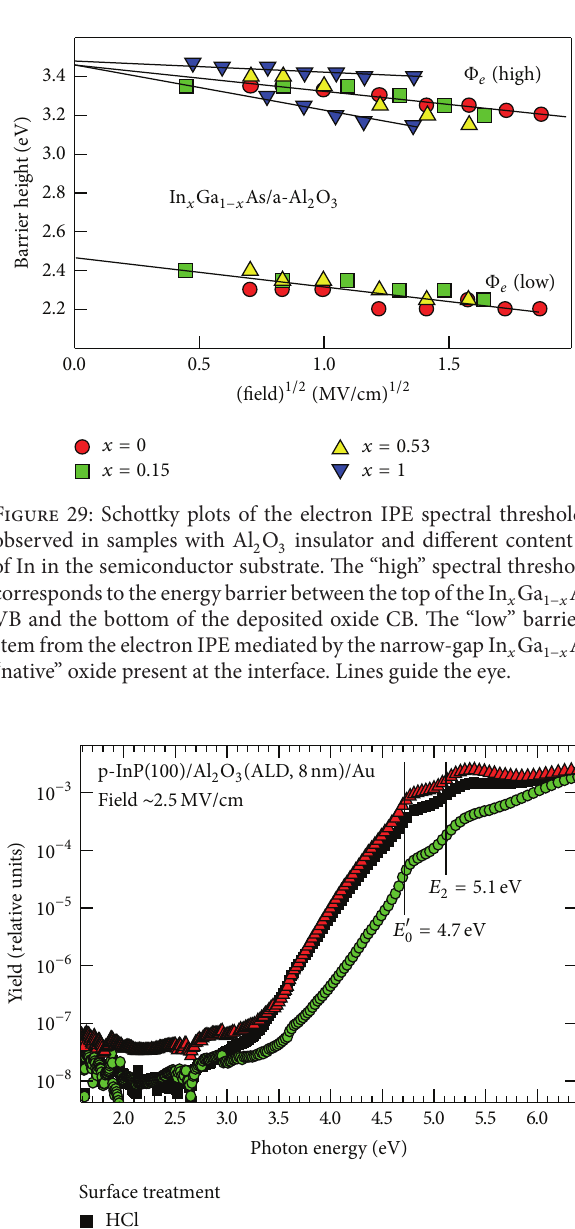
Figure 30: Semilogarithmic plot of the IPE quantum yield as a function of photon energy as measured on p-type (100)InP/a- Al 2 O 3 (8nm)/Au samples prepared by using different InP surface treatments prior to the alumina growth by ALD. The vertical arrows 𝐸 𝐸 0 and 2 mark the energy of direct optical transitions in the InP